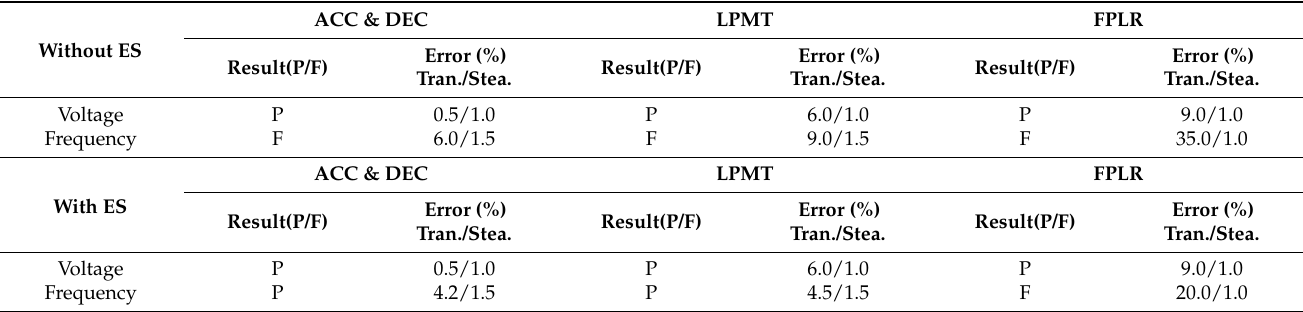
Table 2. Electrical characteristics according to the operation